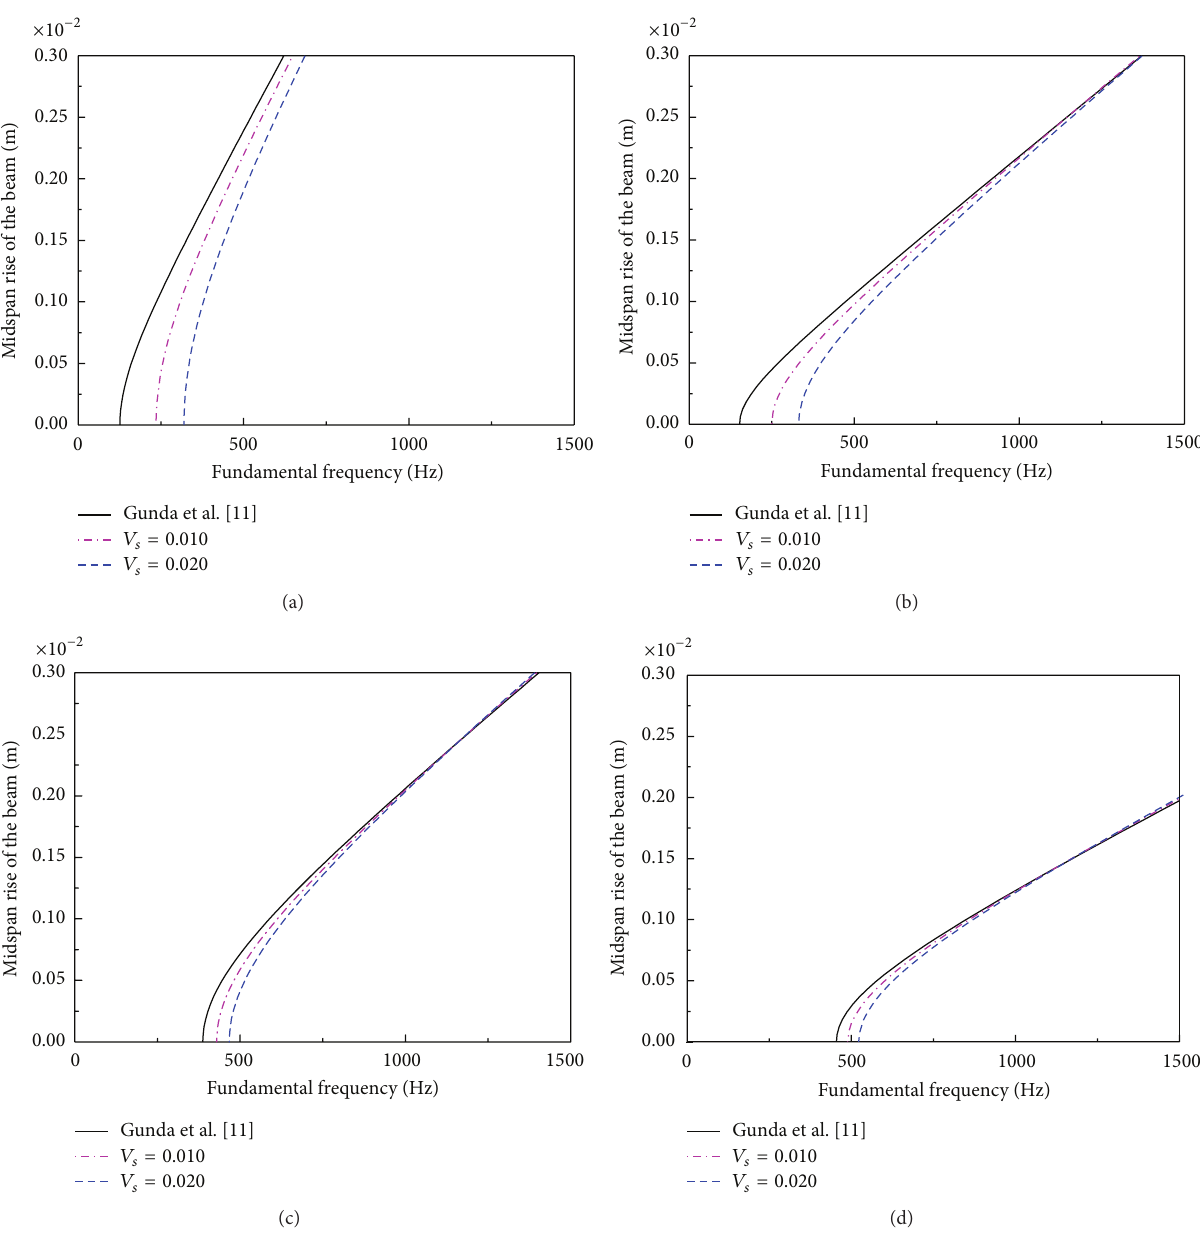
Figure 1: Large amplitude vibration behavior of laminated composite beams with symmetric layup orientations ( 𝑇 = 50 ∘ C, 𝜀 0 = 0.03 ): (a) ; (c) [0 ∘ /90 ∘ /90 ∘ ] ; and (d) unidirectional. cross-ply; (b) [90 ∘ /90 ∘ /0 ∘ ] s s